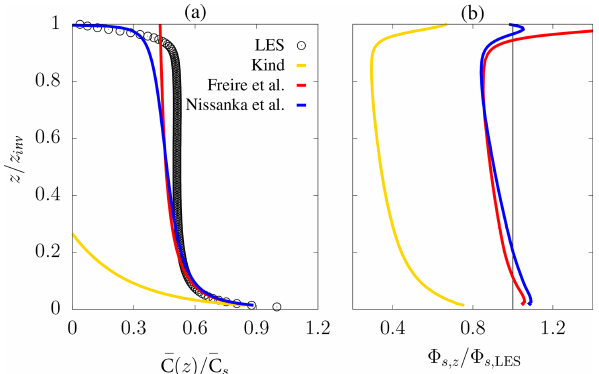
Figure 11. Vertical profiles of the (a) mean particle concentration normalized by its surface value and the (b) estimated surface flux from concentrations at z r and z ( (cid:56) s,z ) normalized by the imposed surface flux in the LES for 10µm diameter particles. Theoretical profiles from the Kind (1992) model (yellow lines), Freire et al. (2016) model (red lines), and Nissanka et al. (2018) model (blue lines), with LES results in circles. Concentration data were obtained from the time and horizontal average of t/T eddy ∼